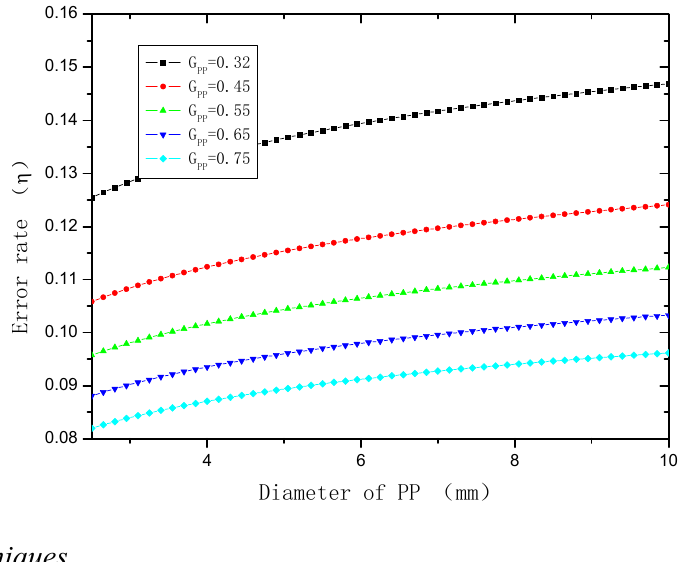
Figure 5. Effect of semi-radius on strain transfer error coefficient.